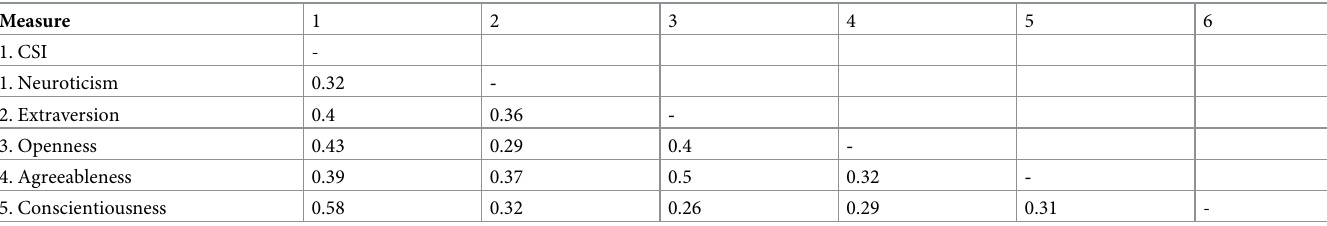
Table 1. The ratios of the CSI with the NEO-FFI resulting from the HTMT method. Measure